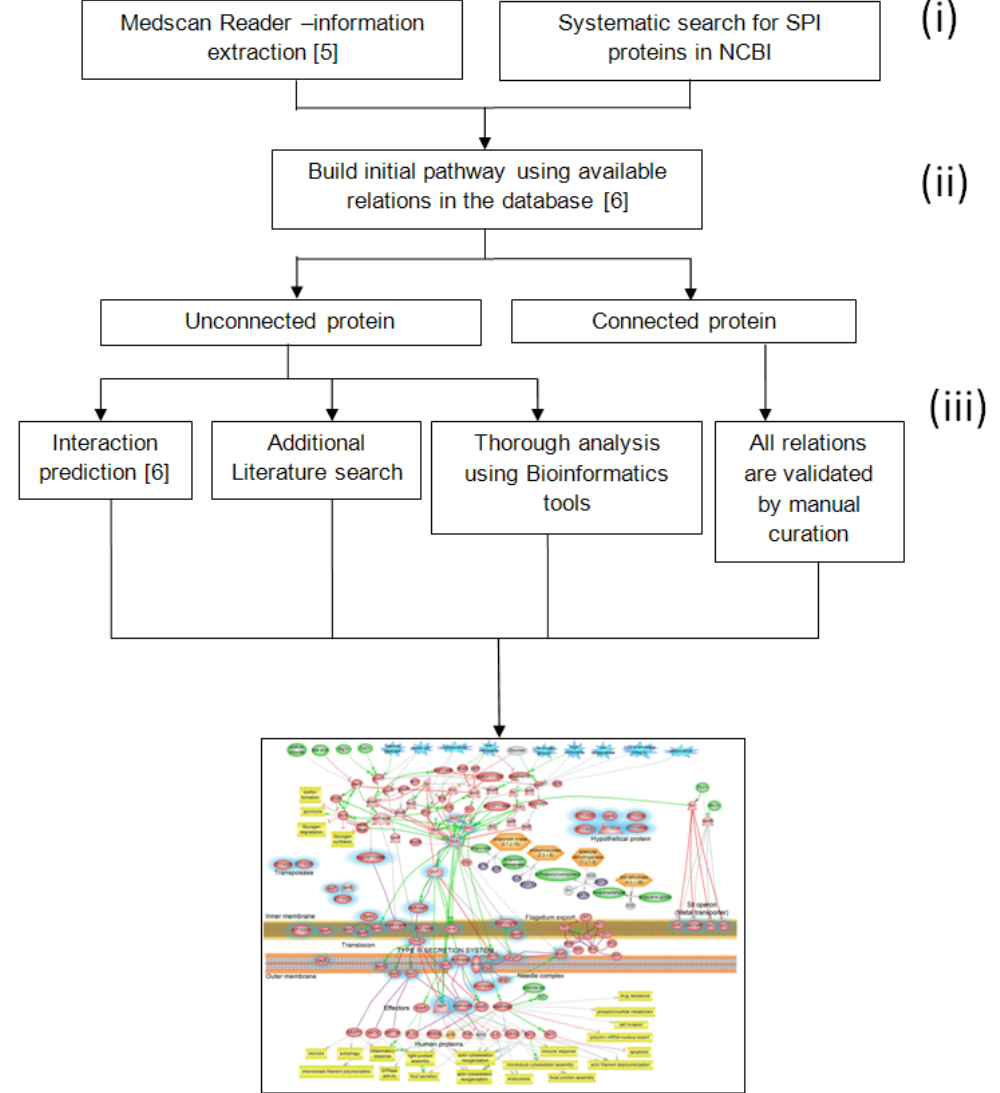
Figure 1: SPI proteins were searched in Salmonella enterica subsp. enterica serovar Typhi str. CT18 genome (GenBank accession NC_003198). Literature search was done through http://www.ncbi.nlm.nih.gov/pubmed. The bioinformatics tools that were used are accessible through http://blast.ncbi.nlm.nih.gov/, http://www.ncbi.nlm.nih.gov/projects/gorf, http://www.ebi.ac.uk/Tools/ClustalW2, http://www.ebi.ac.uk/Tools/Interproscan, http://www.ebi.ac.uk/Tools/emboss/align/index.html,